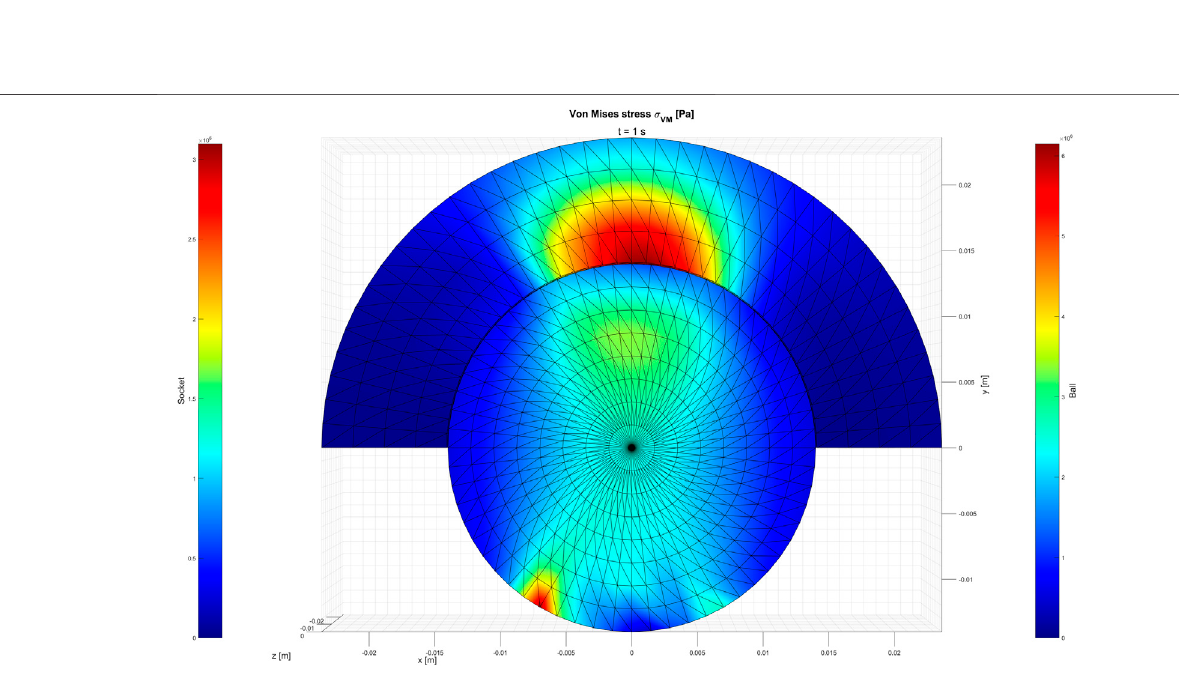
FIGURE 13 | Von Mises stress fi eld inside of the spherical joint.